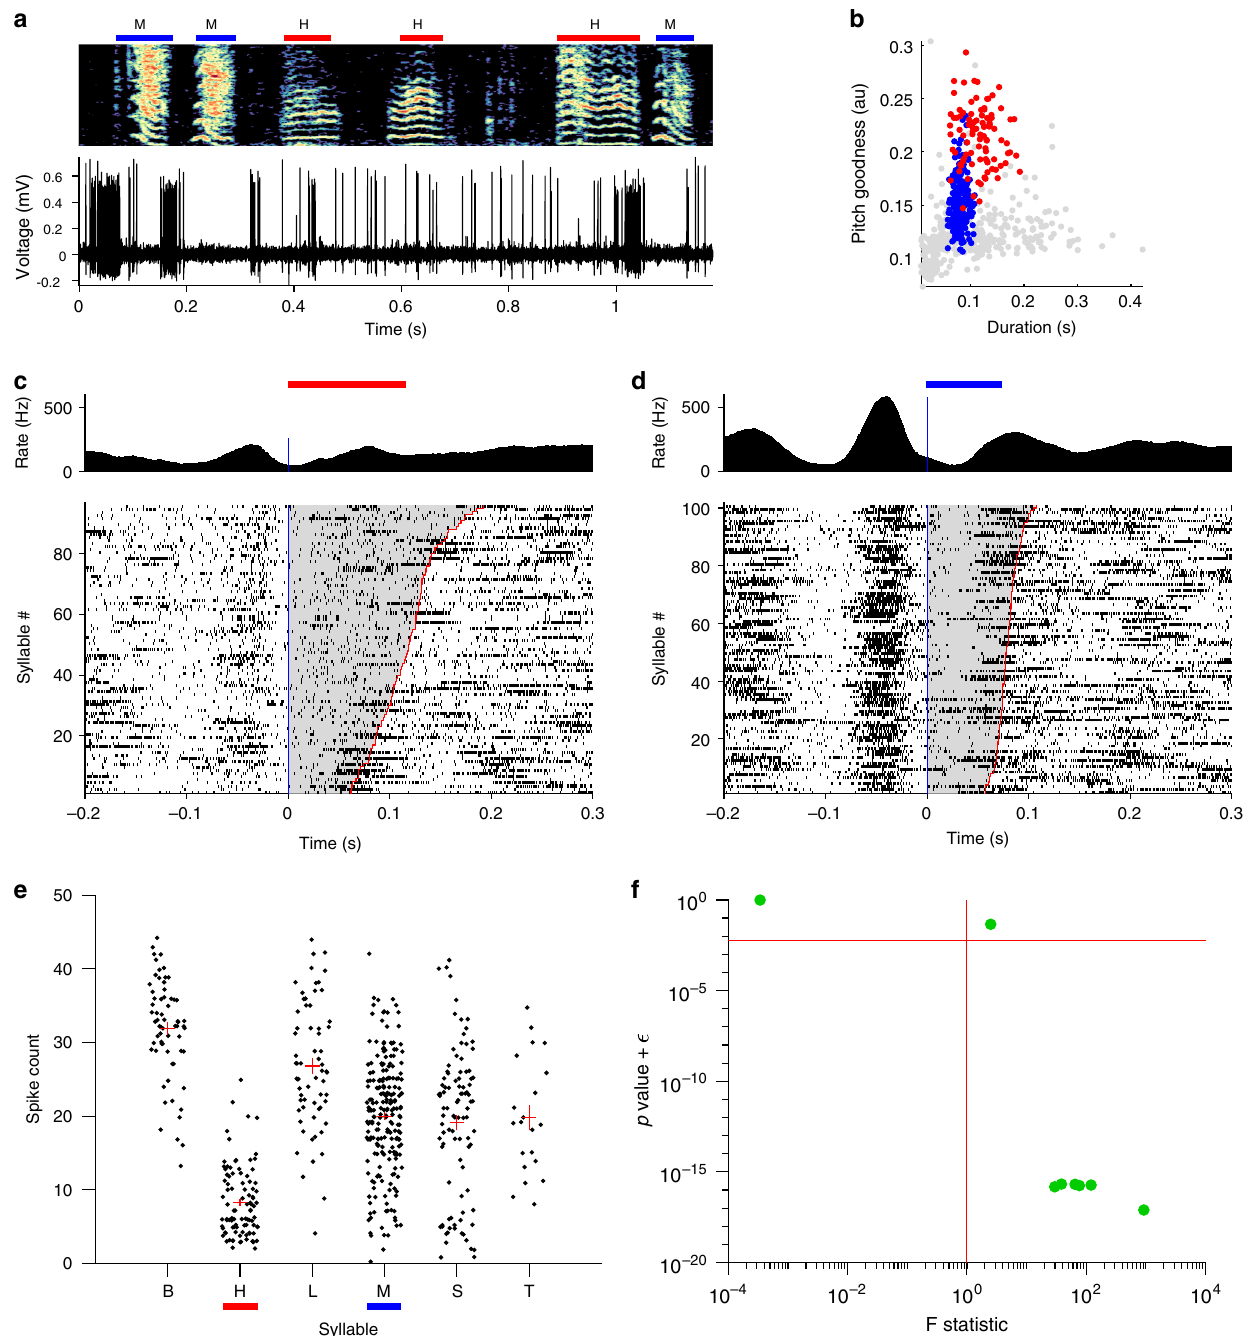
Fig. 4 Syllable selectivity of NIf HVC neuron activity during singing. a Example of a NIf neuron recorded as a juvenile bird sang two different syllable types, marked H and M. b Scatter plot in acoustic feature space of all syllables the bird sang while this neuron was recorded, colored by syllable type. c Onset- aligned raster and PSTH for syllable H, marked by red bar. d Onset-aligned raster and PSTH for syllable M, marked by blue bar. Note that this neuron fi res more before syllable M than syllable H (two-sample t -test, p < 48.2e − 34). e Scatter plots showing spike counts of this neuron across six different syllables types. Spike counts were calculated in a window from 50 ms before syllable onset to 20 ms after syllable onset. Datapoints are jittered for ease of view. A one-way ANOVA was run to assess whether different syllable types had signi fi cantly different mean spike counts ( F = 83.6; p = 2 × 10 − 65 ). Horizontal red lines indicate the mean spike count for each syllable type, and vertical red lines indicate the standard error of the mean. f Scatter plot showing one-way ANOVA p -values and F -statistics for all NIf HVC neurons recorded in birds singing songs with multiple syllable types ( n = 8 projection neurons from two birds). Horizontal red line shows Bonferroni corrected signi fi cance threshold for p = 0.05. Vertical red line indicates F -statistic of